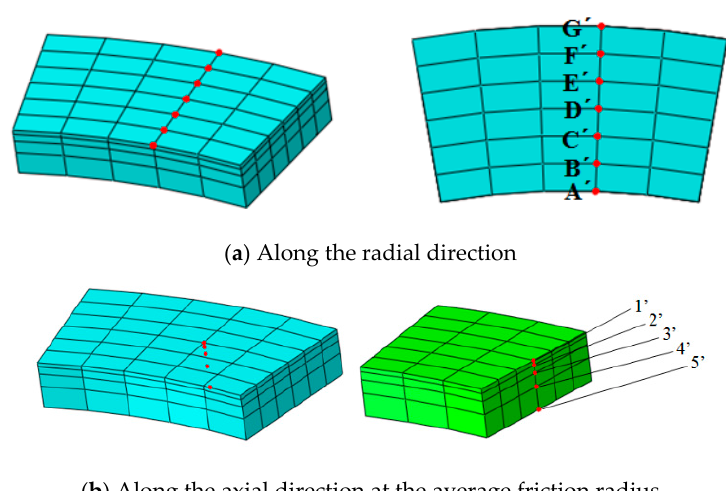
Figure 6. Distributions of nodes along different paths of brake disc.